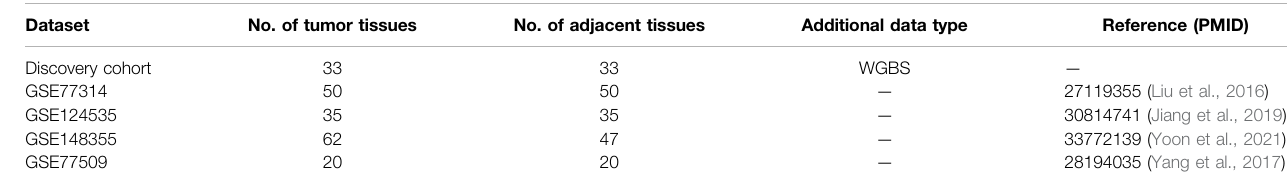
TABLE 3 | Characteristics of fi ve RNA-seq datasets used in the present study.